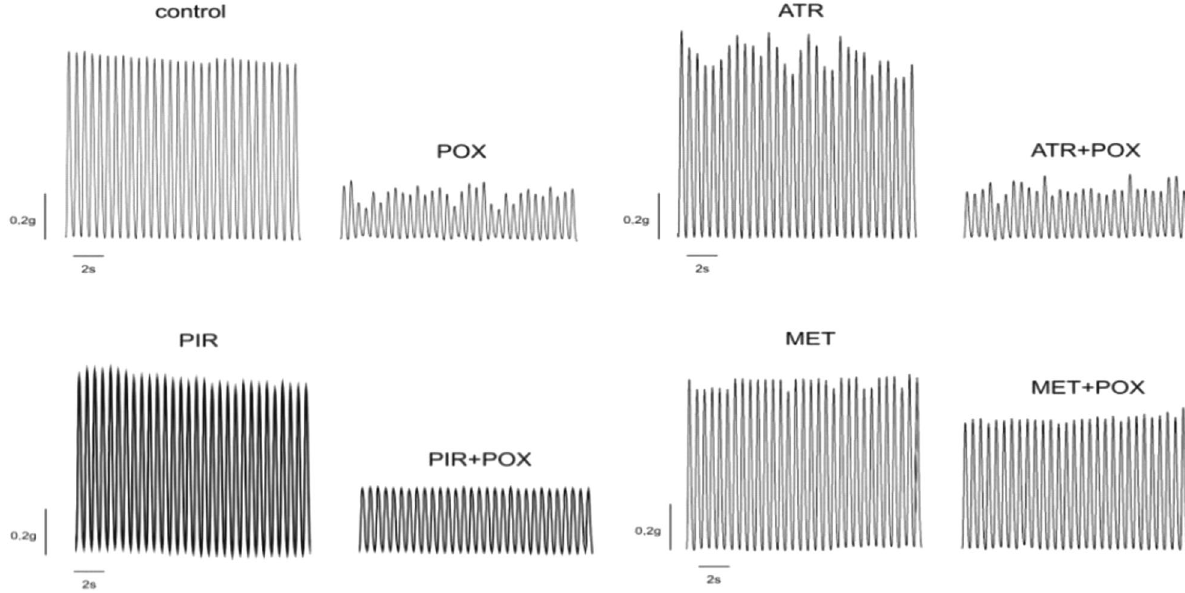
Figure 1. Representative contractions of mouse diaphragm muscle recorded in the presence of 0.5 μM paraoxon (POX), 1 µM atropine (ATR), 1 µM methoctramine (MET) and 0.1 µM pirenzepine